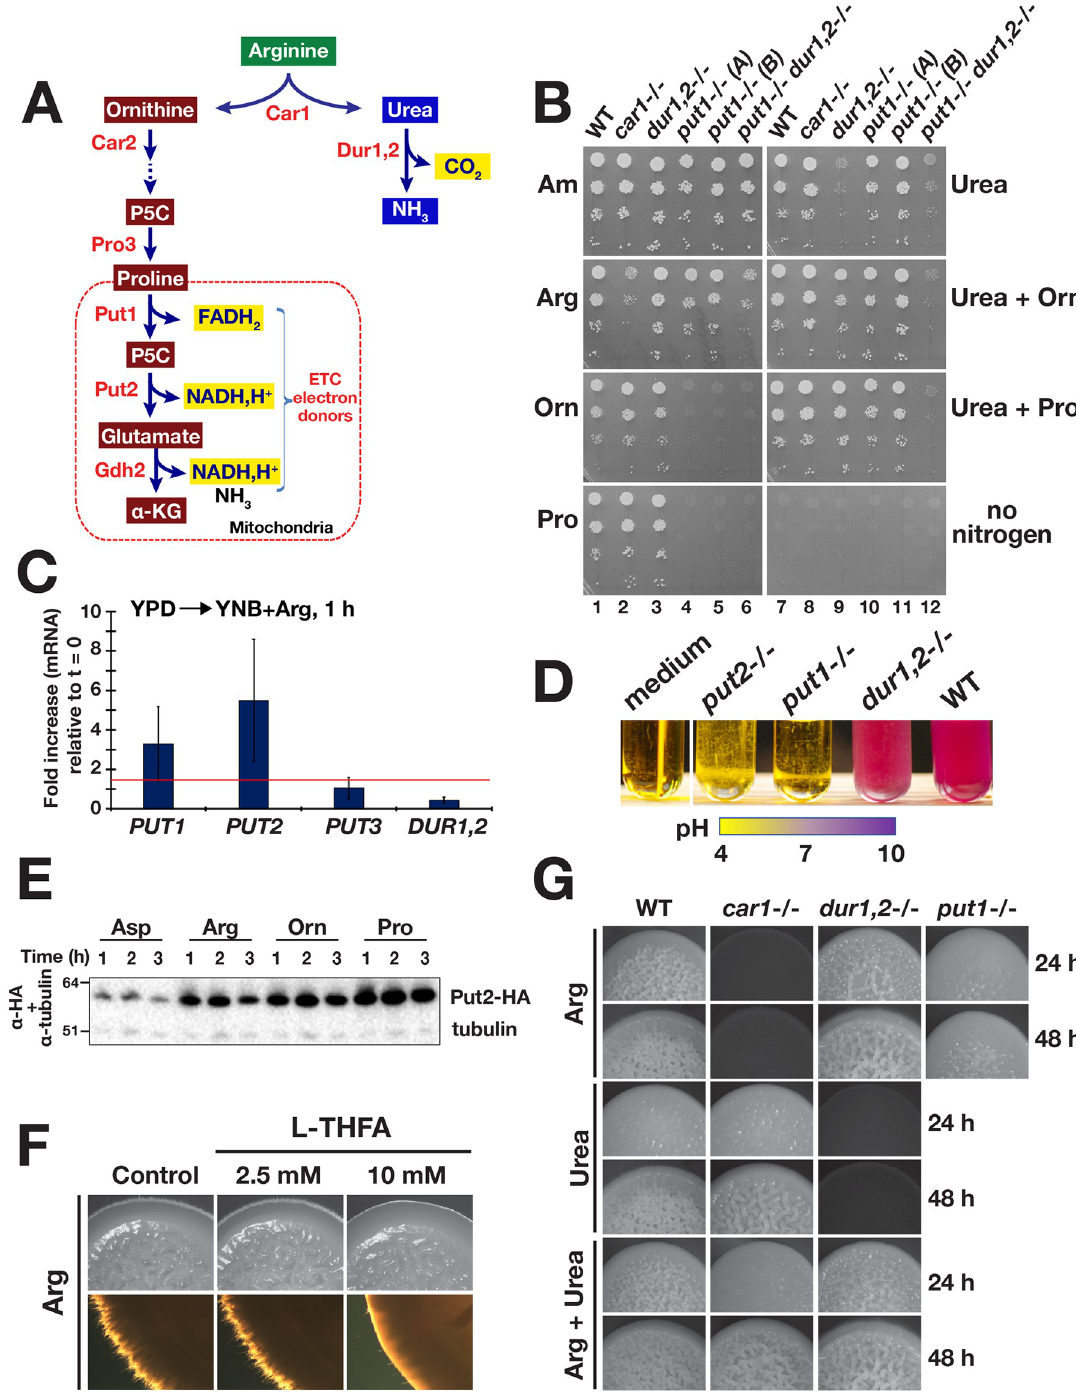
Fig 4. A bifurcated pathway for arginine-induced morphogenesis. A . Scheme of arginine catabolic pathway. B . Growth-based assays. Five microliters (5 μ l) of serially diluted cells were spotted onto the surface of SXD (X = Am (Ammonium sulfate), Arg, Orn, Pro or Urea) and then grown for 48 h at 30˚C. Strains used: wildtype (WT; PMRCA18), car1 -/- (CFG077), dur1 , 2 -/- (CFG091), put1 -/- (A) (CFG122), put1 -/- (B) (CFG155), and put1 -/- dur1 , 2 -/- (CFG158). C . Arginine rapidly derepresses proline catabolic genes. PUT1 , PUT2 , PUT3 and DUR1 , 2 expression in wildtype (SC5314) cells 1 h at 37 ˚C after shifting from YPD (t = 0) to YNB+Arg (pH = 6.0). Gene expression was determined by qRT-PCR using the levels of RIP1 to normalize expression. D . Proline catabolic pathway is required for growth in arginine as a sole nitrogen and carbon source. Cells with the indicated genotypes were harvested from log phase YPD